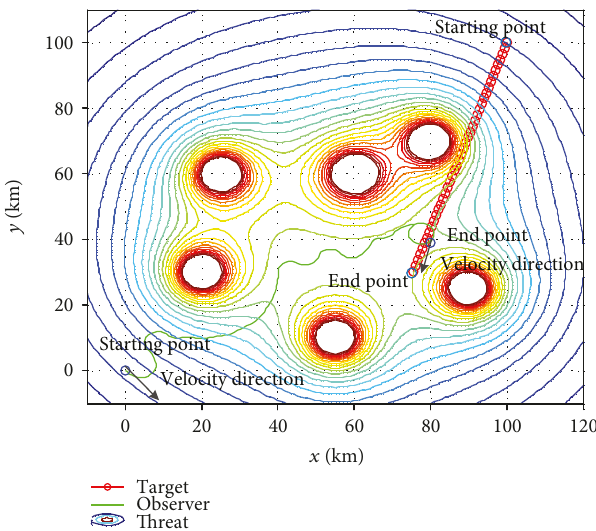
Figure 10: “ Trap ” problem in threats environment in scenario 6.